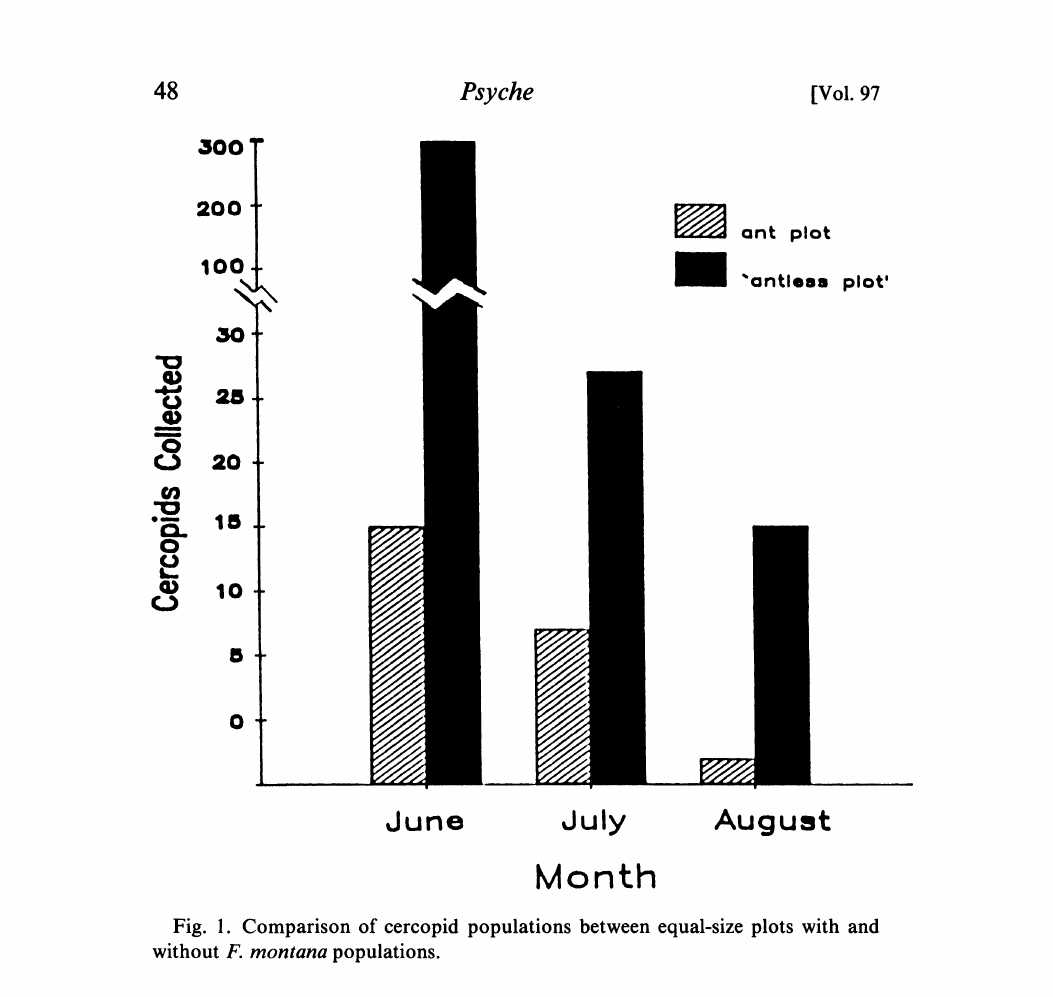
Fig. 1. Comparison of cercopid populations between equal-size plots with and without F. montana